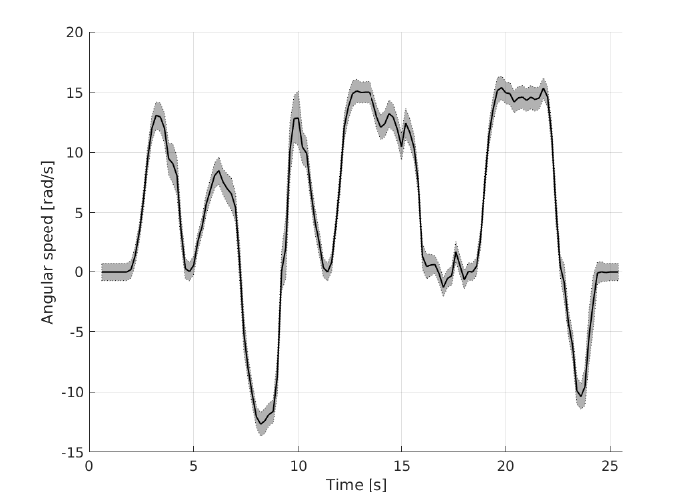
Figure 6. Prediction intervals (95% confidence level) of GP model predicted